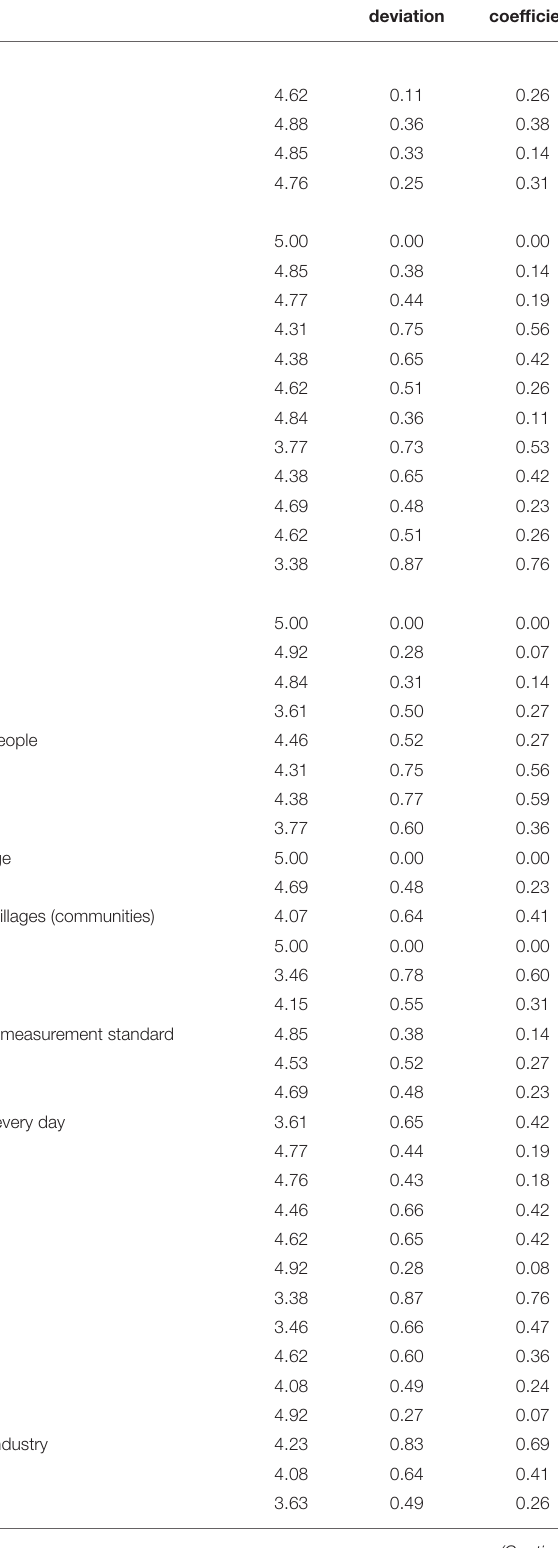
TABLE 4 | Statistical results of evaluation indicators at all levels. Indicators Mean Standard Factor layer index ( W = 0.62) Stakeholder